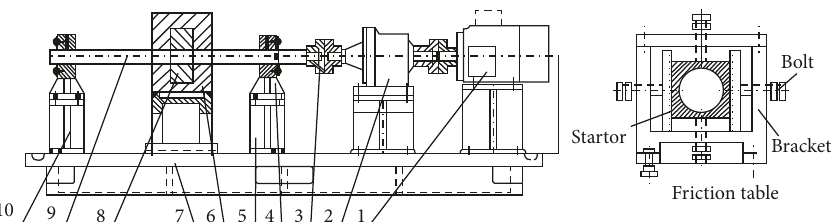
Figure 4: Test bed of rotor friction emitting AE. 1: electric motor; 2: acceleration box; 3: shaft joint; 4: bearing; 5: shaft block 1; 6: friction table; 7: base; 8: turntable; 9: axle; 10: shaft block 2.